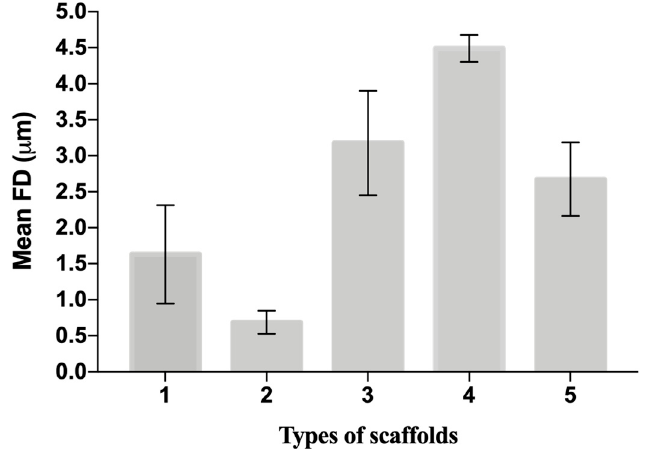
Figure 4. The mean value and spread of the first five scaffolds from DiameterJ. The histogram shows simultaneously the Y 1 and Y 2 of each scaffold from Table 4. Data are expressed as the mean ± SD ( p -values < 0.05 is the significance interval).